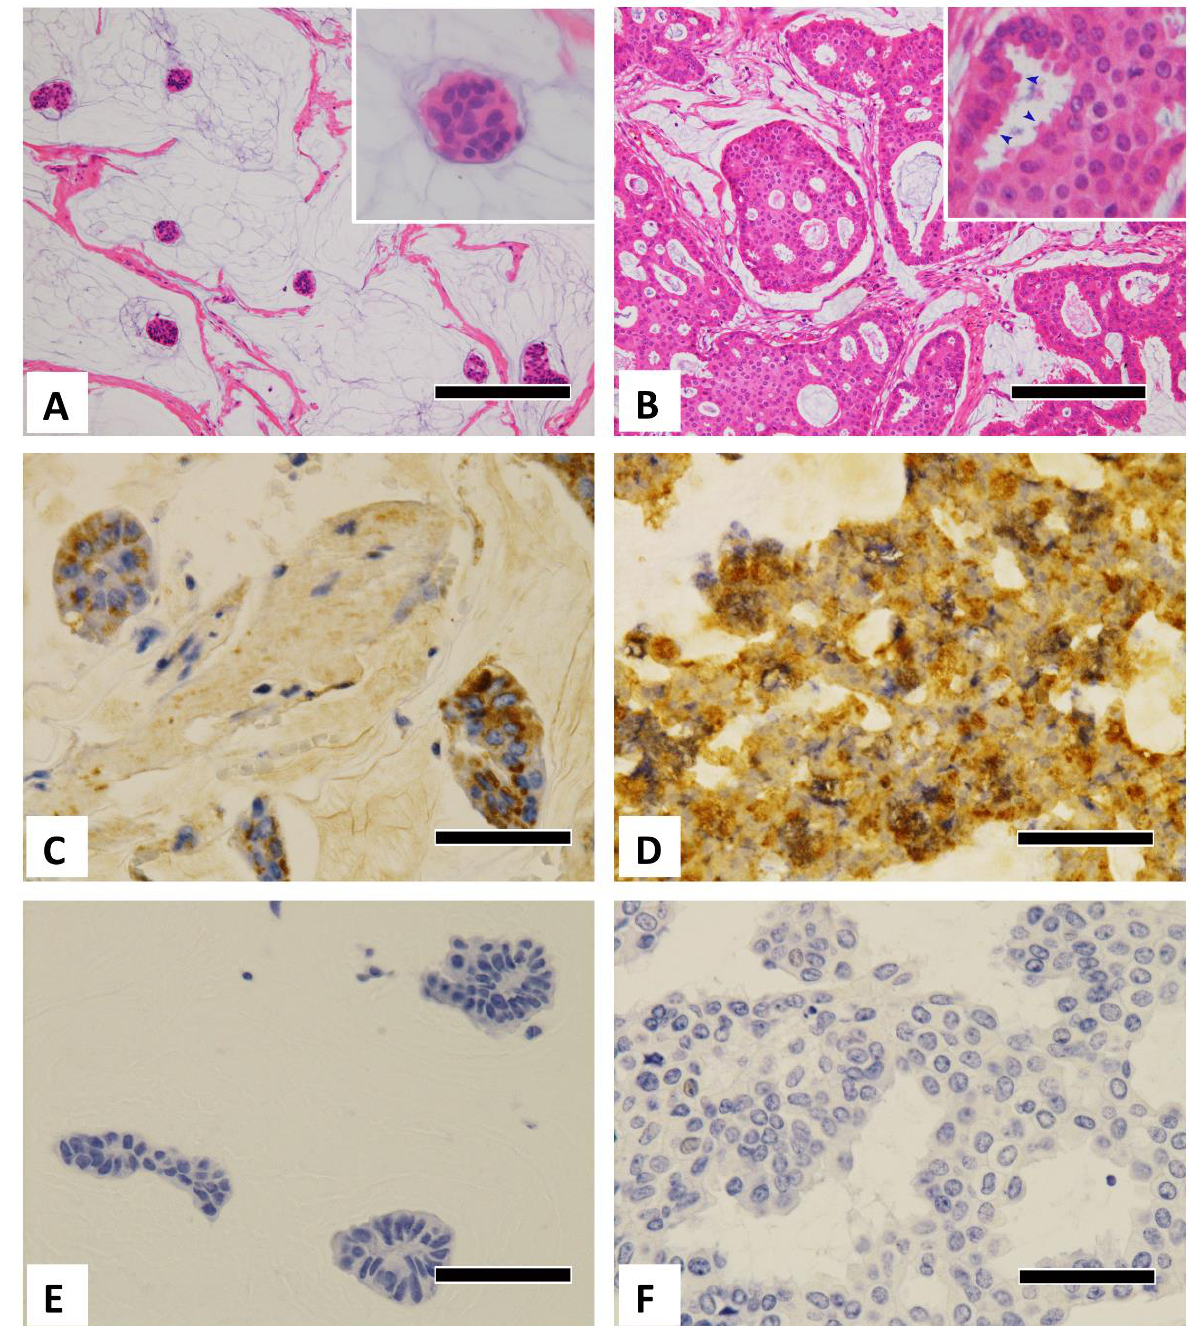
Figure 1. Microscopic pictures of breast mucinous carcinoma. ( A ) Histological image of a type A mucinous carcinoma. Note tubular and papillary small clusters with a large amount of extracellular mucin (HE stain). The inset shows a magnified image. ( B ) Histological image of a type B mucinous carcinoma. Large epithelial clumps or sheets composed of tumor cells with eosinophilic cytoplasm and a small amount of extracellular mucin (HE staining). The magnified image inset shows tumor cells with apocrine snouts (arrowheads) and abundant eosinophilic cytoplasm. ( C ) Older, type A (immunohistochemical pictures of GCDFP-15 positivity). ( D ) Older, type B (immunohistochemical pictures of GCDFP-15 positivity). ( E ) Younger, type A (immunohistochemical pictures of GCDFP-15 negativity). ( F ) Younger, type B (immunohistochemical pictures of GCDFP-15 negativity). GCDFP-15: gross cystic disease fluid protein-15. Scale bar = 200 μm ( A , B ), 50 μm ( C – F ).